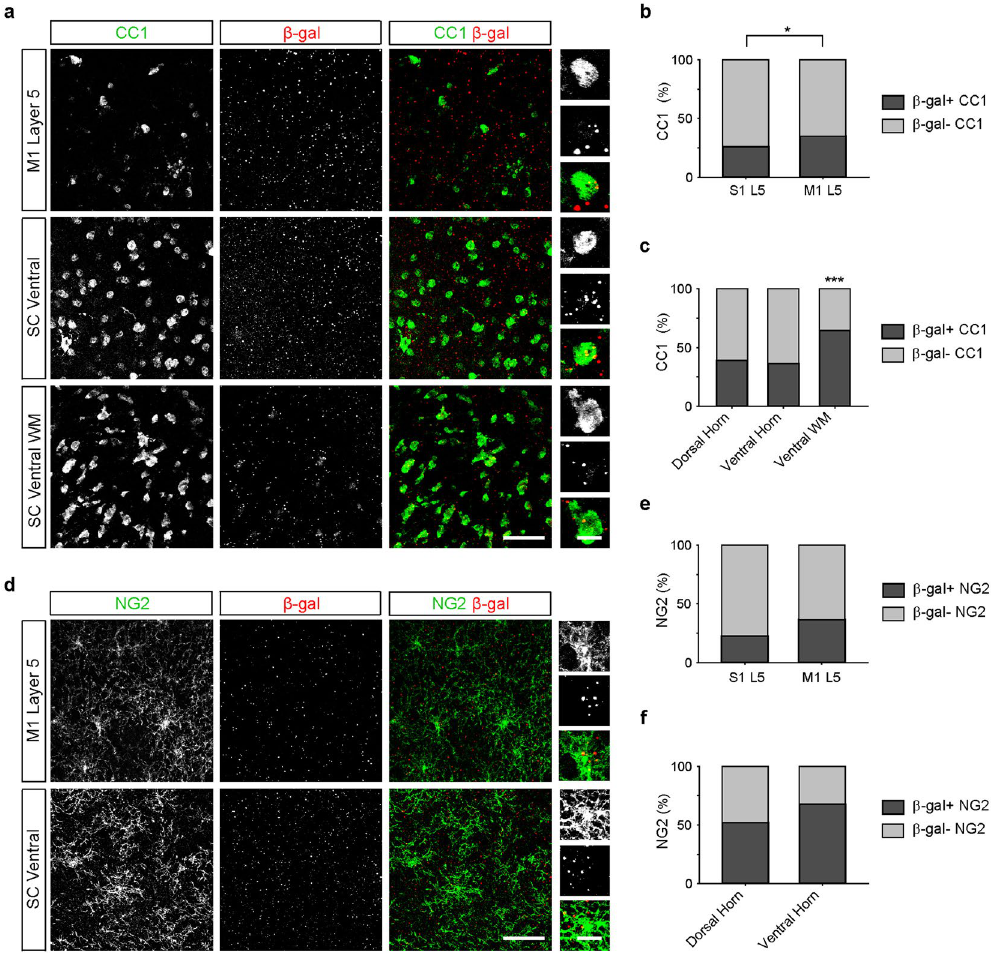
Figure 7. C9orf72 promoter activity in oligodendrocytes and OPCs is enriched in cortical regions associated with neurodegeneration in amyotrophic lateral sclerosis. ( a ) Representative images of layer 5 (L5) of the primary motor cortex (M1, top), ventral horn of the spinal cord (SC, middle), and the ventral white matter of the spinal cord (SC WM, bottom) of C9orf72 LacZ/ + mice immunostained for CC1-positive oligodendrocytes (green) and β -gal (red). High magnification images show colocalization of β -gal puncta within oligodendrocytes (right panels).The percentage of oligodendrocytes containing β -gal puncta in L5 of primary somatosensory (S1) and motor (M1) cortex ( b ) S1 L5: 38 of 167 cells, 26.0%; M1 L5: 82 of 234 cells, 35.0%; n = 5 mice for each group, p = 0.0140, Chi-Square test) and spinal cord ( c ) dorsal spinal cord: 209 of 533 cells, 39.2%; ventral spinal cord: 191 of 525 cells, 36.4%; spinal cord white matter: 283 of 438 cells, 64.6%, n = 3 mice for each group, p < 0.0001 Chi-Square) ( d ) Representative images of L5 of primary motor cortex (M1, top) and the ventral horn of the spinal cord (bottom) immunostained for NG2-positive oligodendrocyte precursor cells (OPCs; green) and β -gal (red). High magnification images show colocalization of β -gal puncta within oligodendrocytes (right panels). The percentage of OPCs containing β -gal puncta in L5 of primary motor (M1) and primary somatosensory (S1) cortex ( e ) S1 L5: 21 of 92 cells, 22.6%; M1 L5: 33 of 92 cells, 36.5%; n = 5 mice for each group, p = 0.0520, Chi- Square test) and spinal cord ( f ) dorsal spinal cord: 39 of 75 cells, 52.0%; ventral spinal cord: 44 of 65 cells, 67.7%; n = 3 mice for each group, p = 0.0594, Chi-Square test). Scale bars: 50 μ m and 10 μ